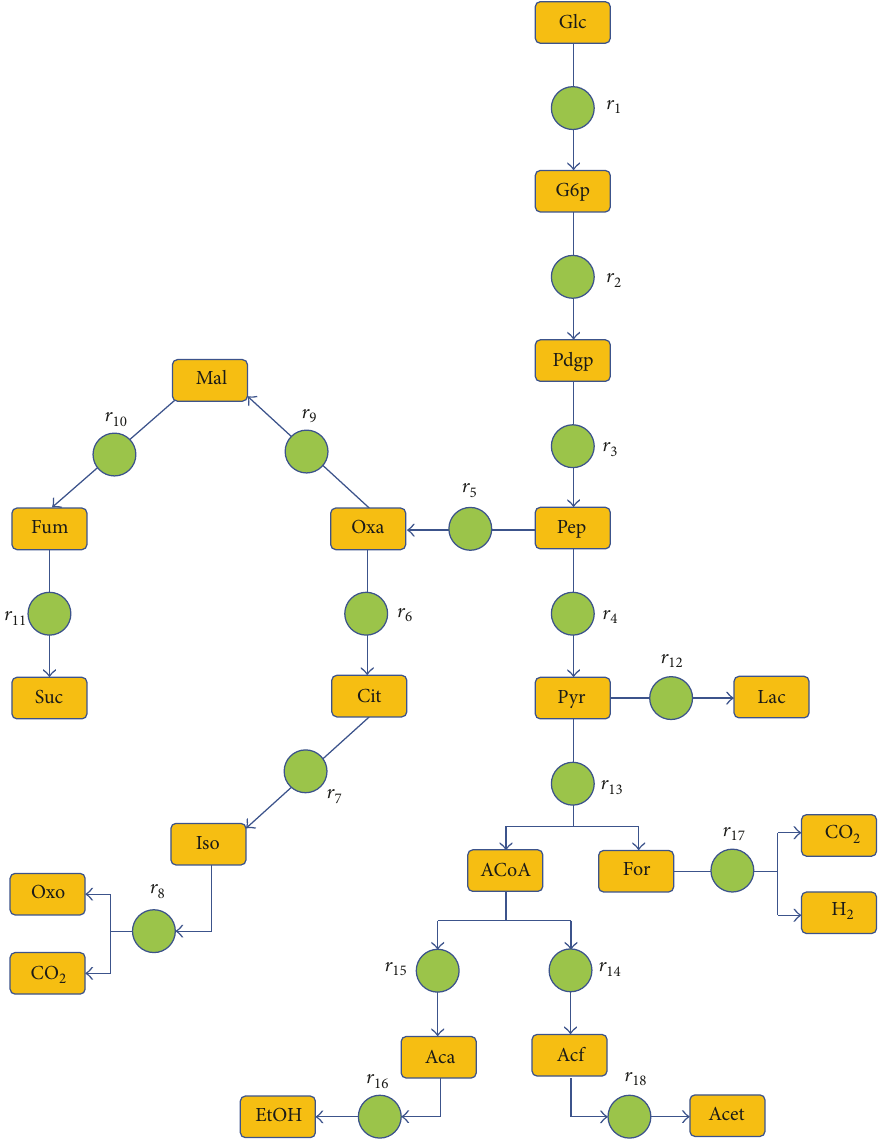
Figure 1: Metabolic pathway of hydrogen production in Escherichia coli